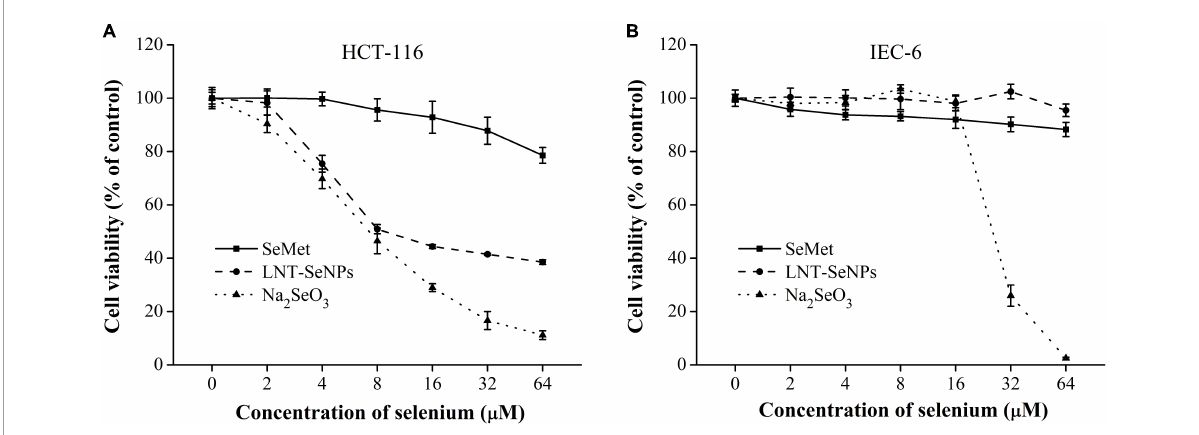
FIGURE5 Cytotoxic effects of LNT-SeNPs, Na 2 SeO 3 , and SeMet on HCT-116 (A) and IEC-6 cells (B) at the concentration range of 2–64 µ M. Data were shown as mean values ± SD ( n = 6).